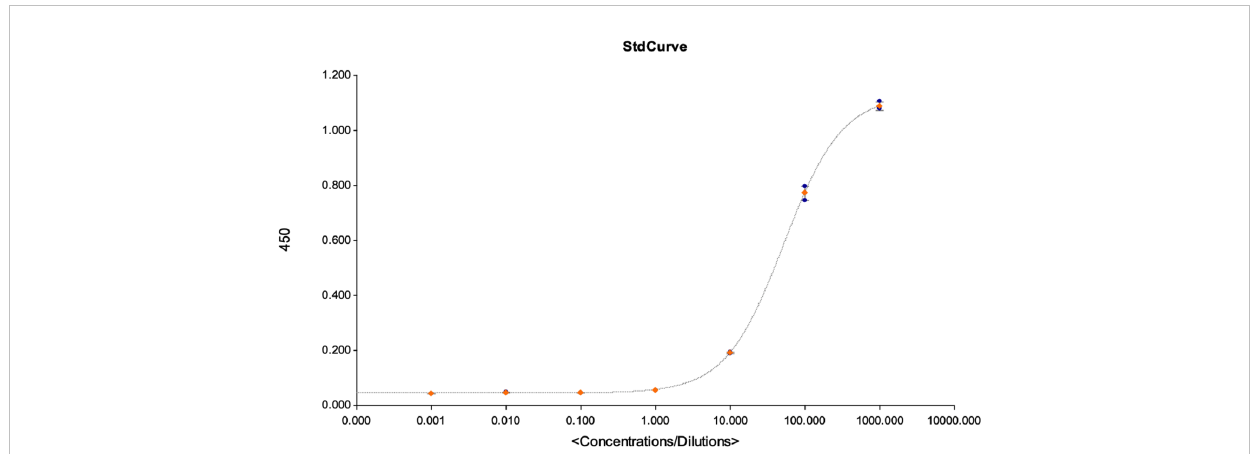
FIGURE 7 This fi gures shows the goodness of fi t curves that were used as a criterion for accepting the assay for quanti fi cation of the detected antibodies. The graph is an illustration of a standard curve used for extrapolating antibody concentrations from OD450 values, and to calculate the assays LOD, LOQ and LOB at linearity R 2 >